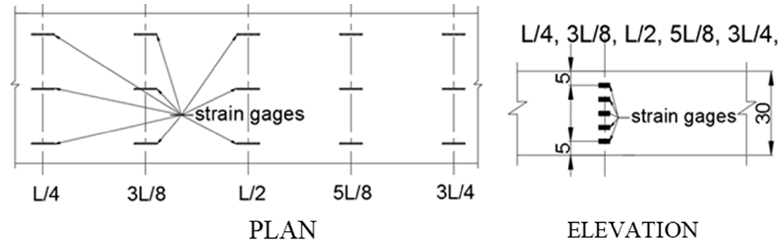
Figure 2. The plan and elevations views of the strain gauge setups.